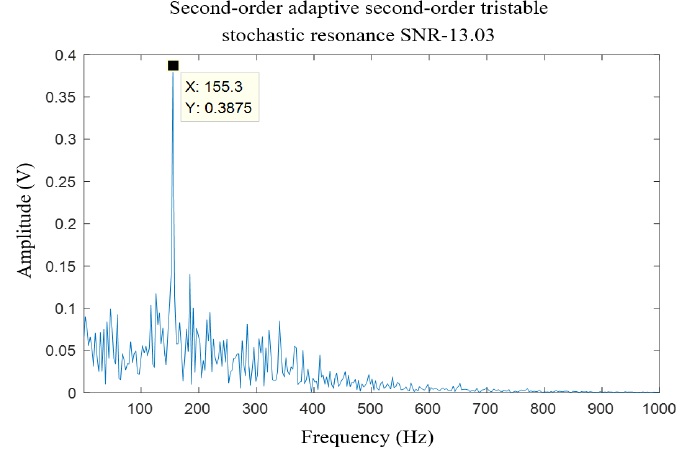
Figure 17. The output spectrum of the second cascade system.